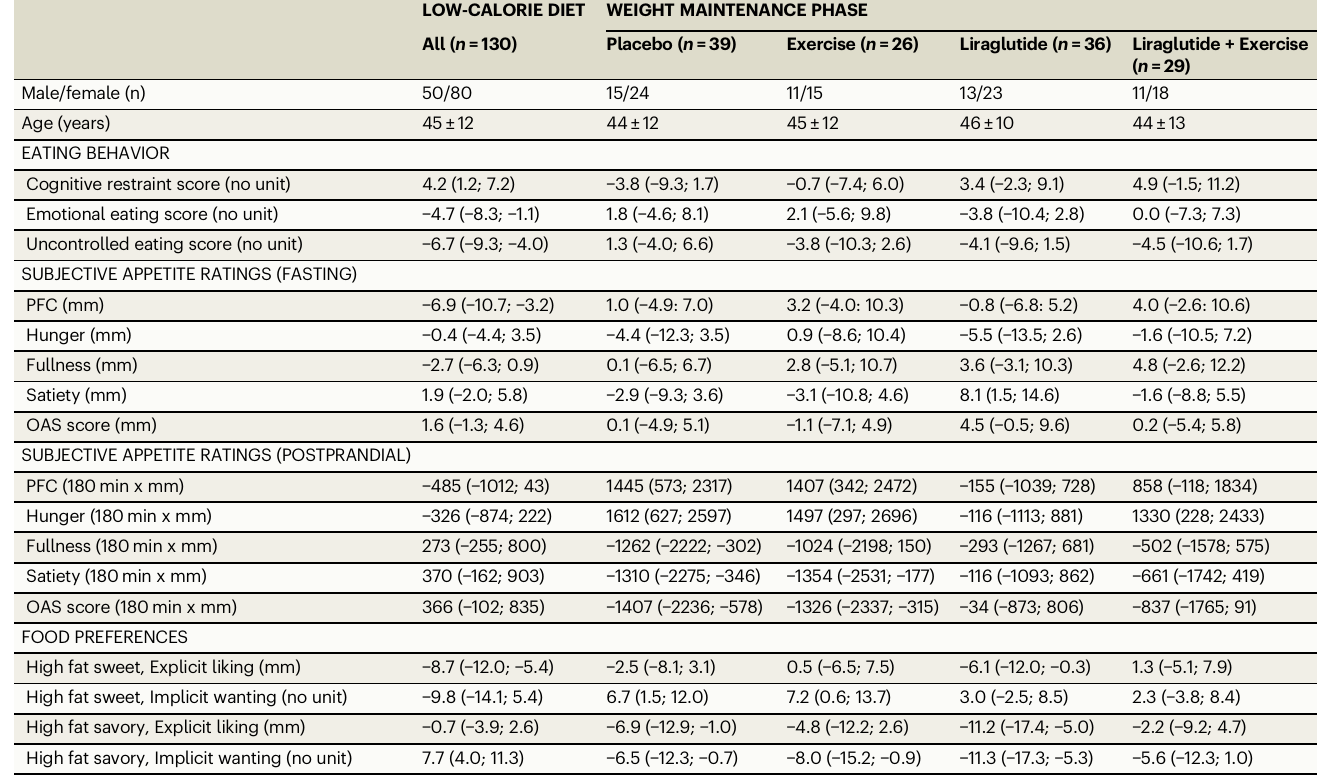
OAS overall appetitesuppression, PFC prospective food consumption. Resultsarepresentedforstudyparticipantswhoadheredtothestudyinterventions(per-protocol)asestimatedmeanchanges(95%CI)duringthelow-caloriedietforallgroupscombinedandforthe four groups separately from randomization toweek52. Values were estimated from a linear mixed model withtime, group, sex, age, anda timegroup interaction as fi xed effects.